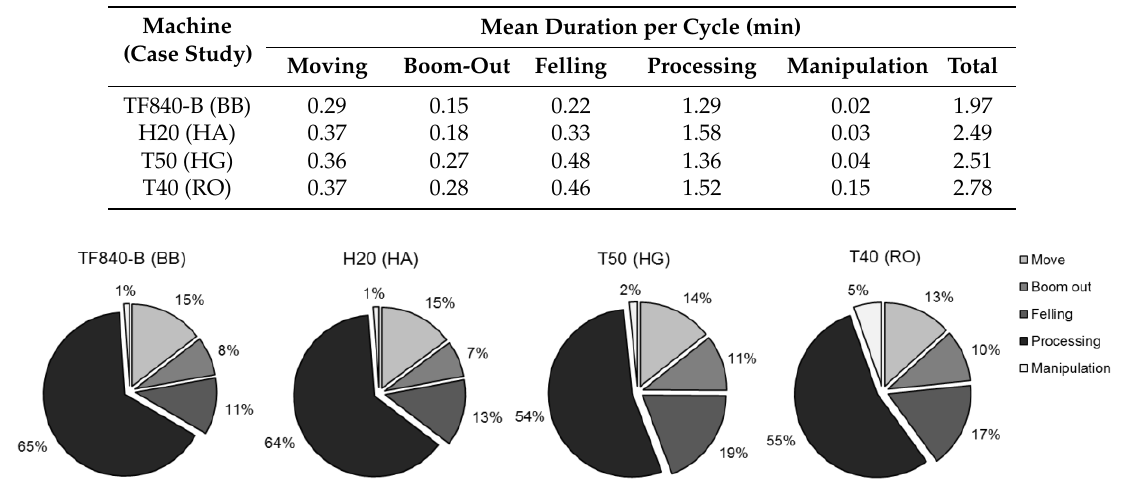
Figure 3. Mean share of cycle duration for the individual work elements in the fully-mechanized (FM) group. (FM)